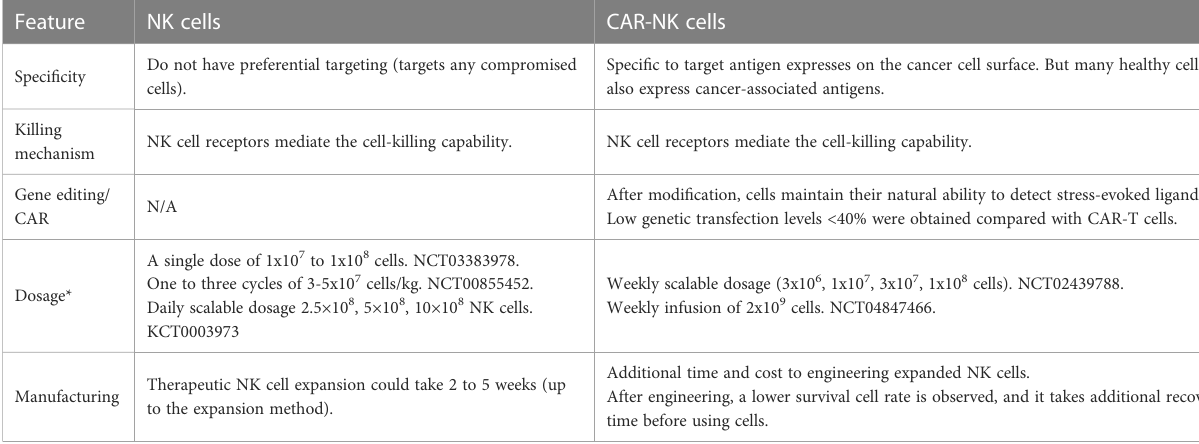
TABLE 4 Comparison of NK and CAR-NK cell products. Feature NK cells CAR-NK cells Do not have preferential targeting (targets any compromised Speci fi city cells). Killing